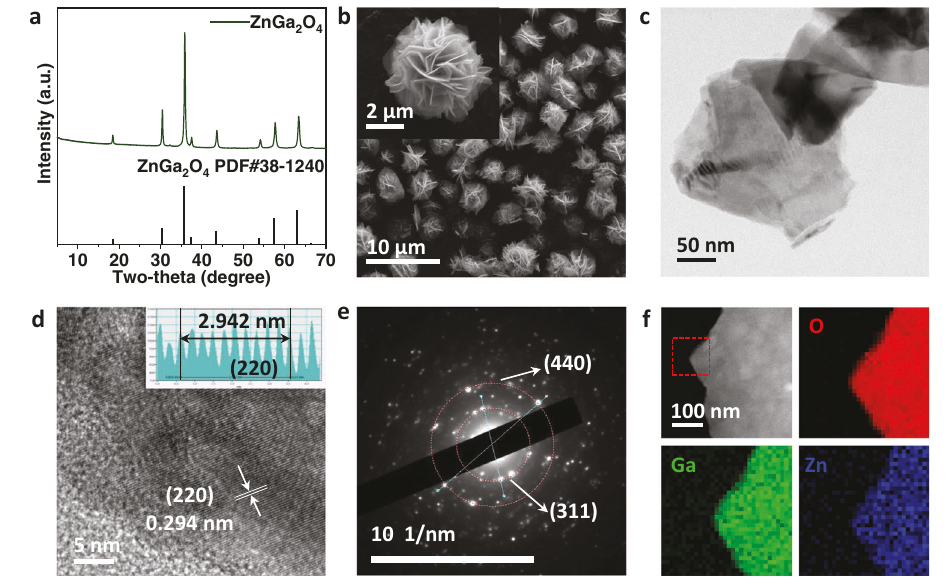
Fig. 1 | Morphological characterizations of ZnGa 2 O 4 . a X-ray diffraction pattern of the prepared ZnGa 2 O 4 . b SEM images of ZnGa 2 O 4 . c TEM image. d HRTEM image. e Polycrystalline electron diffraction pattern of ZnGa 2 O 4 .